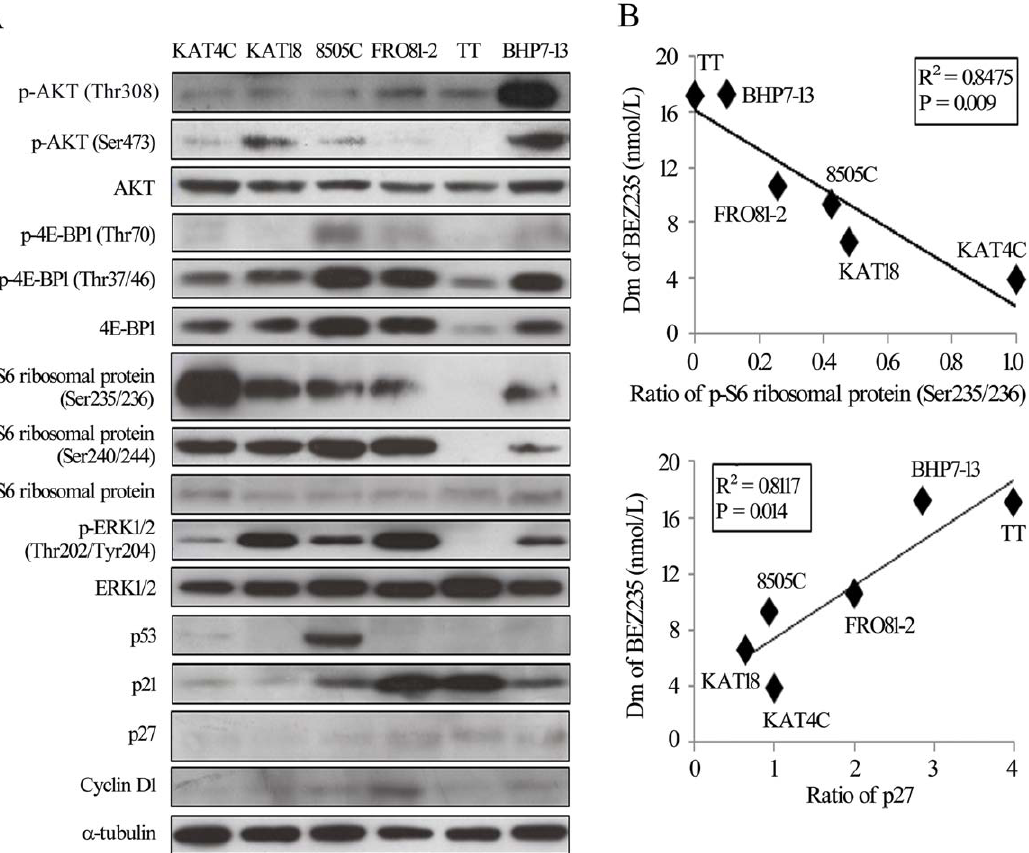
Figure 4. Susceptibility to BEZ235 correlates with baseline expression of p-S6 ribosomal protein (Ser235/236) and p27. A, the baseline levels of proteins associated with signaling transduction and cell cycle were evaluated by immunoblot. The sequence of proteins loaded was according to Dm. The expression of p-S6 ribosomal protein (Ser235/236) gradually decreased from KAT4C to BHP7-13, while p-27 showed the opposite order. The expression of the other proteins showed a random distribution. B, Band densities were imaged and quantified. Relationships between Dm and protein expression were analyzed using Pearson’s correlation coefficients, and graphs were drawn using KAT4C. The expression of p-S6 ribosomal protein (Ser235/236) had a positive correlation, and p27 an inverse correlation, with sensitivity to BEZ235.